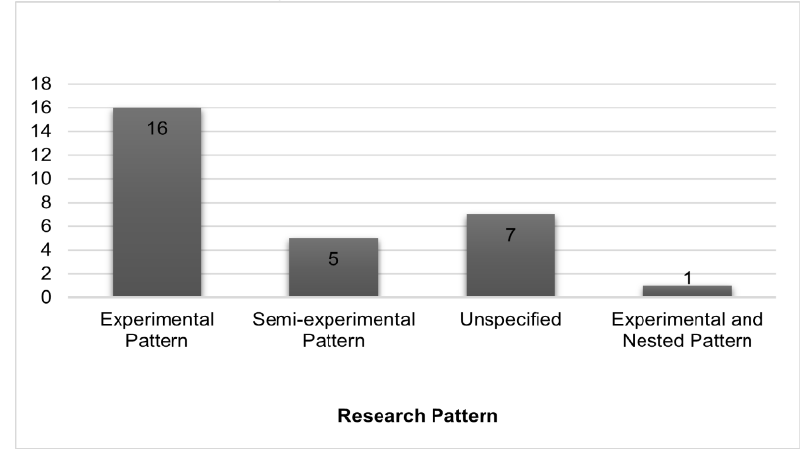
Figure 4: Distribution of Studies According to Research Pattern